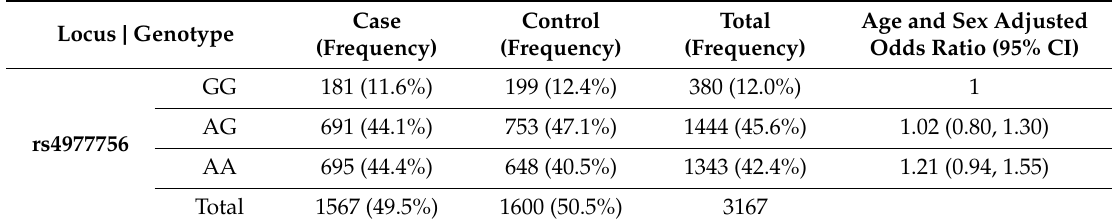
Table 1. Association between rs4977756 genotypes and Primary open-angle glaucoma (POAG) disease status (case vs. control). Analyses controlled for age and sex.